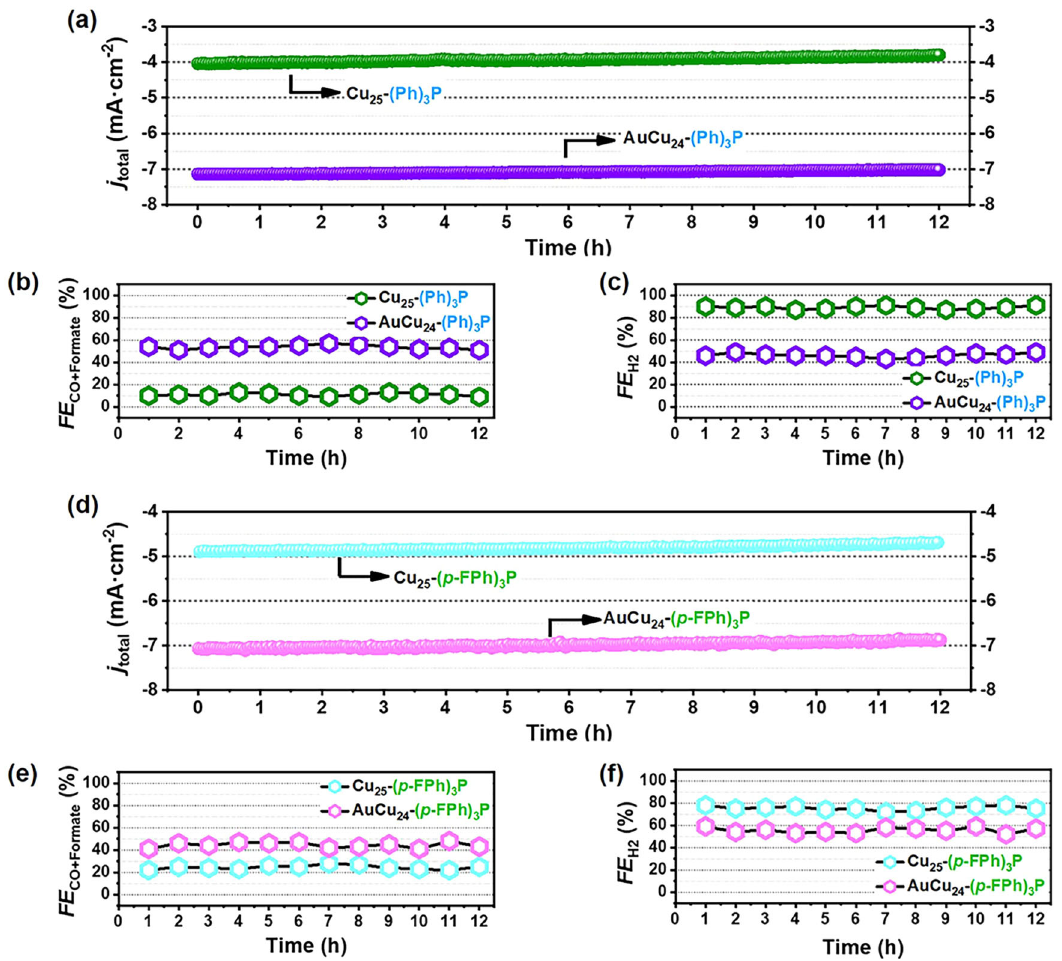
Fig. 3 Long-term stability of Cu 25 -(Ph) 3 P, AuCu 24 -(Ph) 3 P, Cu 25 -( p- FPh) 3 P and AuCu 24 -( p- FPh) 3 P at − 0.80 V. a , d i-t curve; FEs of b , e C 1 products and c , f H 2 at different